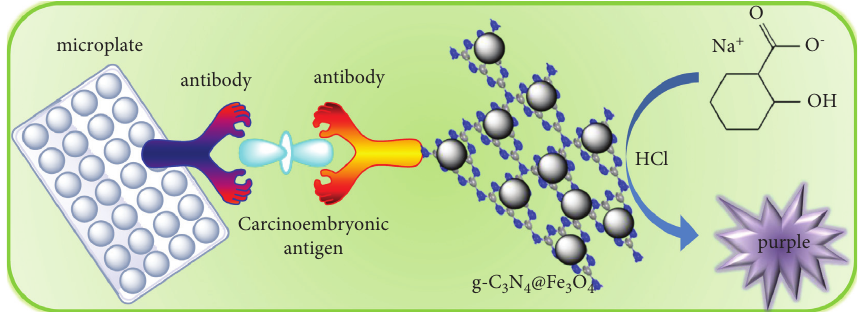
Scheme 1: Schematic illustration of colorimetric immunoassay for target CEA